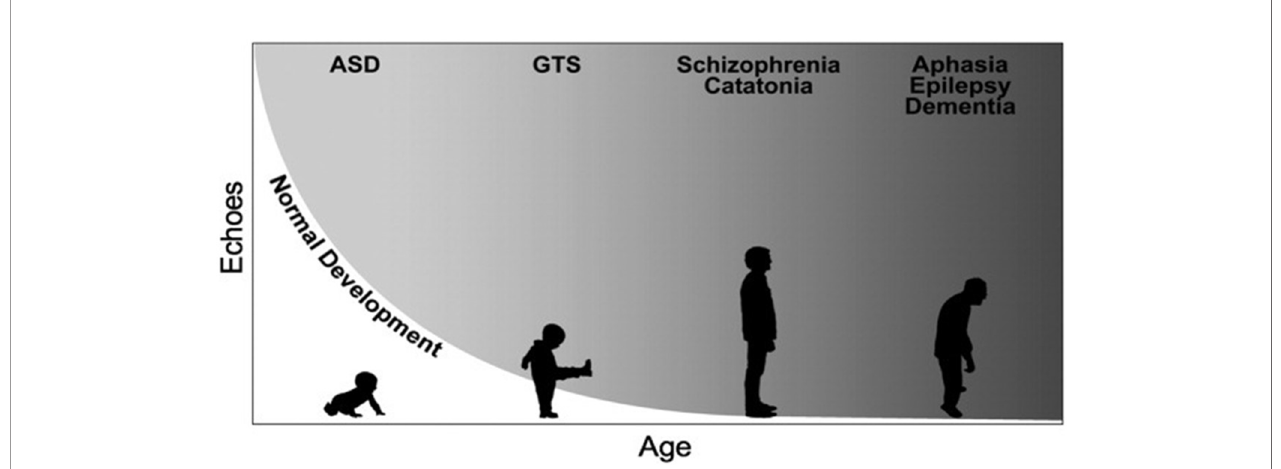
FIGURE 1 | Simpli fi ed representation of the developmental trajectories of echophenomena in health and disease. Echophenomena are present in normal childhood development, with a gradual reduction throughout the fi rst three years of life (depicted trajectory in white). Gray shades demonstrate the persistence or reemergence of echophenomena as a sign of underlying neuropsychiatric disorders, e.g., in autism spectrum disorders (ASD), Gilles de la Tourette syndrome (GTS) or others [ fi gure republished with permission from Wiley publishing,